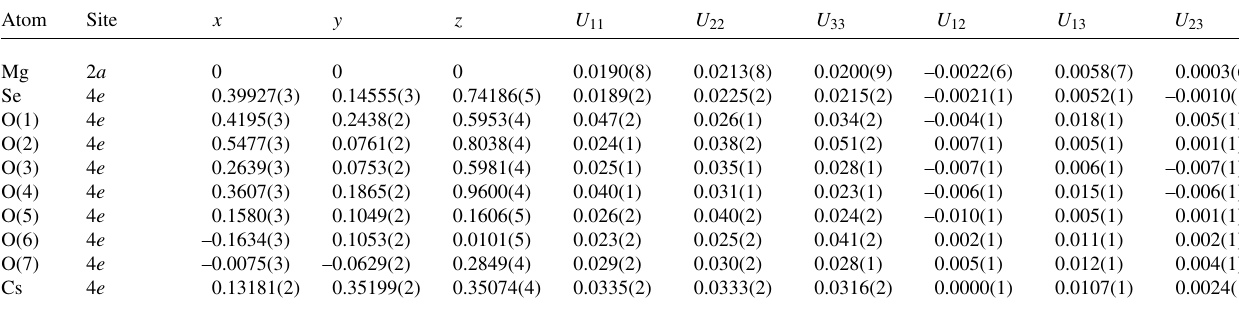
Table 3. Atomic coordinates and displacement parameters (in Å 2 ) .